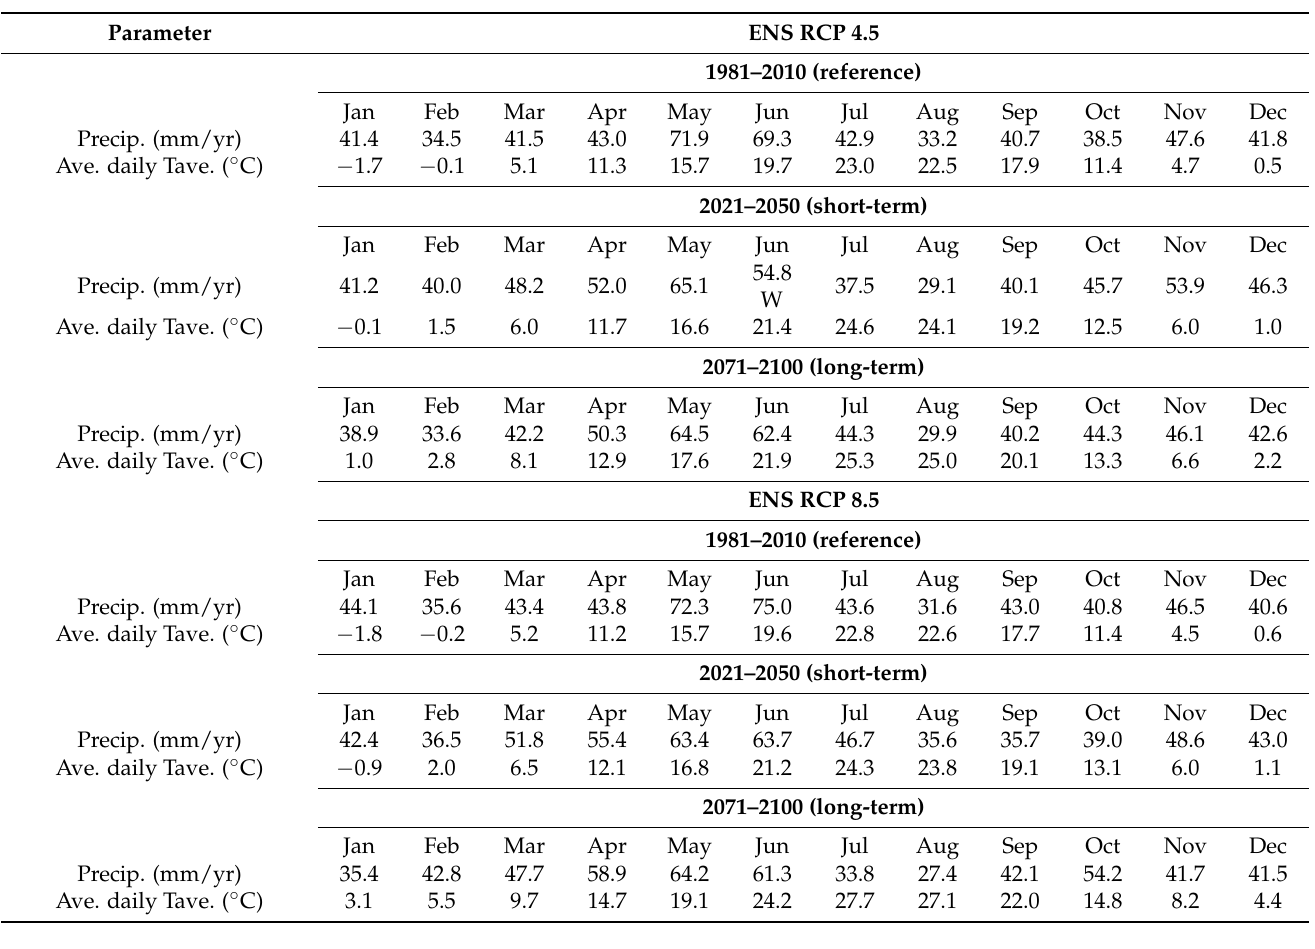
Table 3. Monthly values for the representative year for average temperature and precipitation amount for each climate model ensemble output for the reference, short- and long-term period (catchment scale).